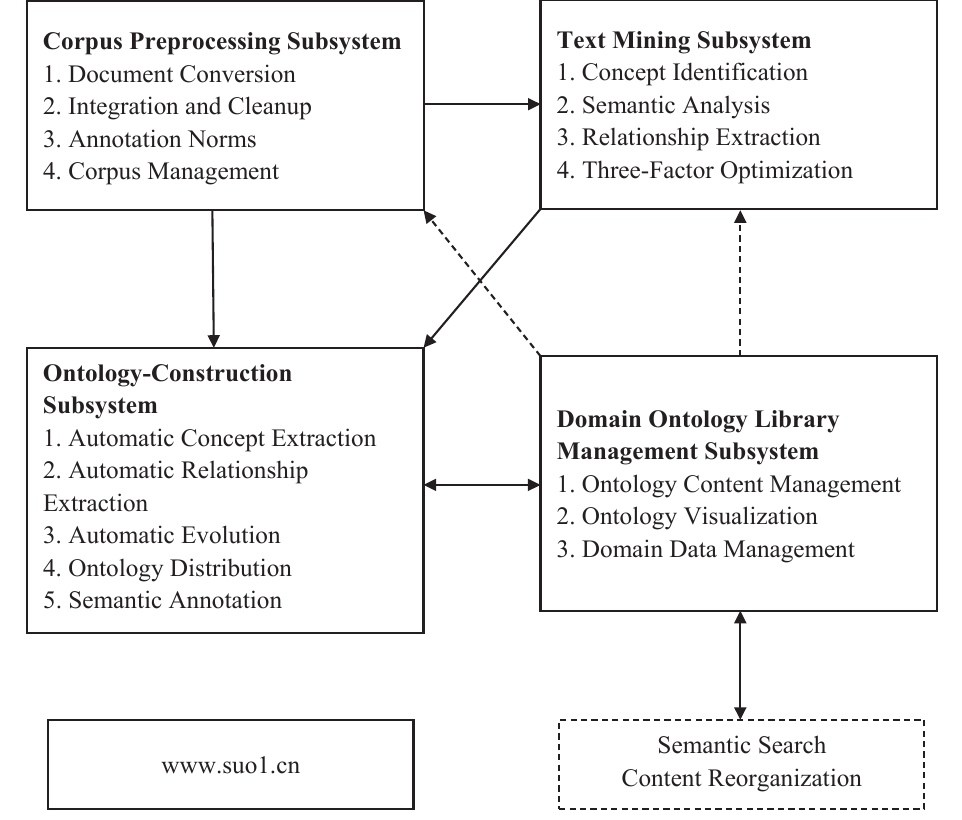
Figure 1. Nursing knowledge-construction system in nursing